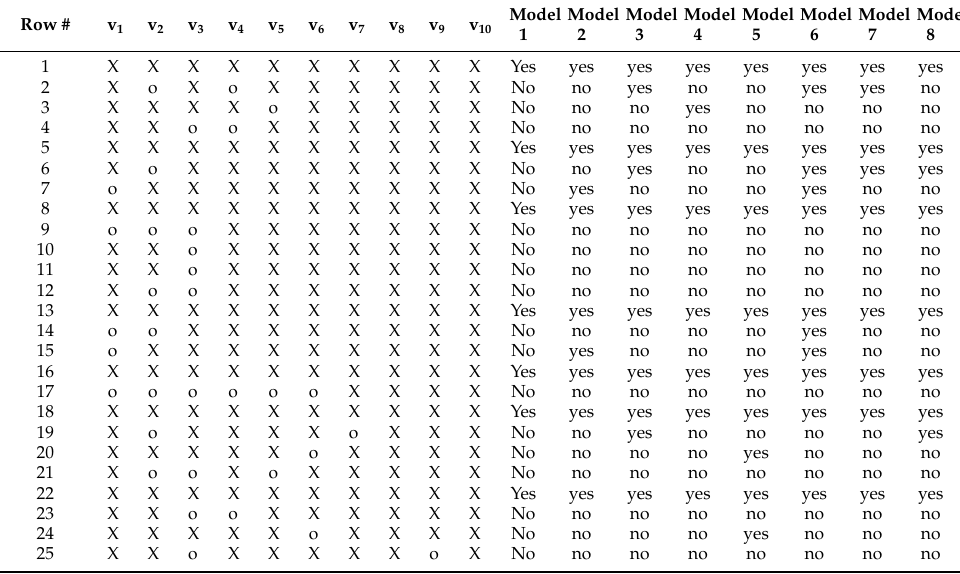
Table 3. Example of the dataset (25 first